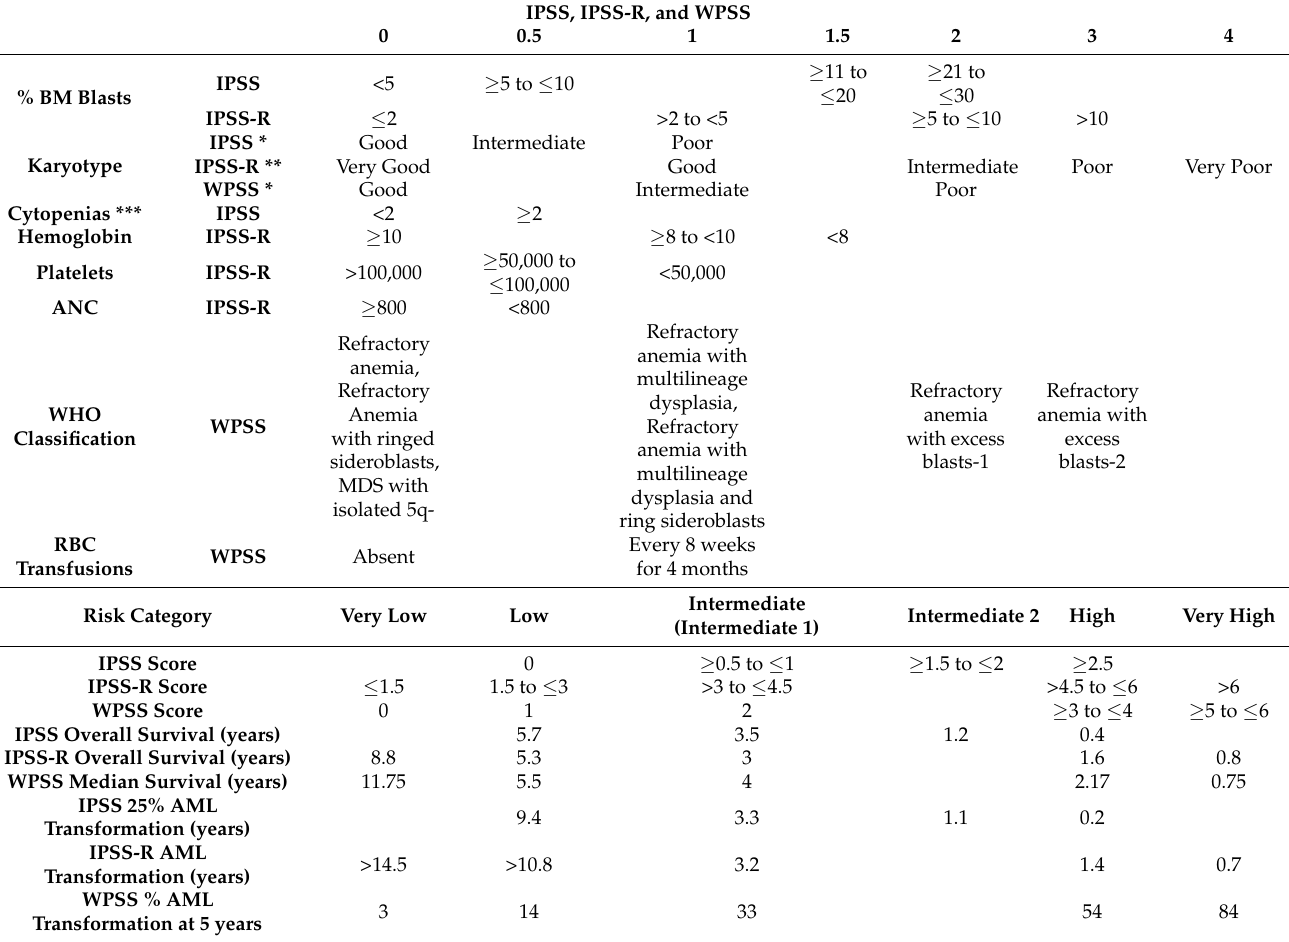
Table 1. Survival and risk of progression to acute myeloid leukemia in myelodysplastic syndrome patients according to the International Prognostic Scoring System (IPSS), the Revised International Prognostic Scoring System (R-IPSS), and the WHO Prognostic Scoring System (WPSS). IPSS, IPSS-R, and WPSS 0 0.5 1